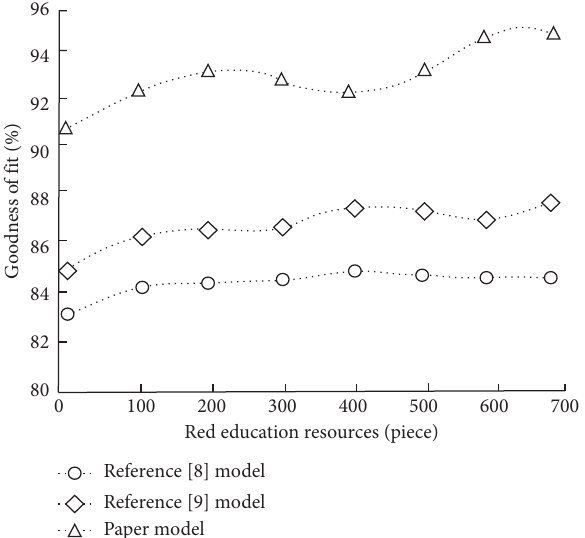
Figure 6: Goodness of fit test results of red education resource integration